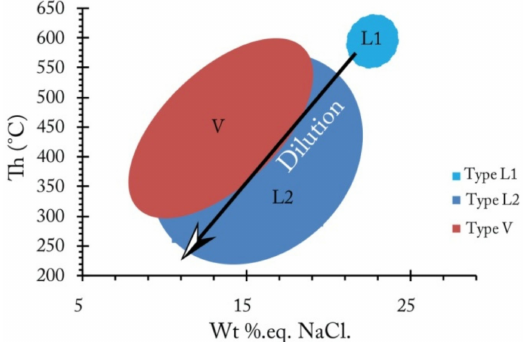
Figure 22. Salinity vs. homogenization temperature scatters plot of fluid inclusions shows the evolution of the salty aqueous fluid of